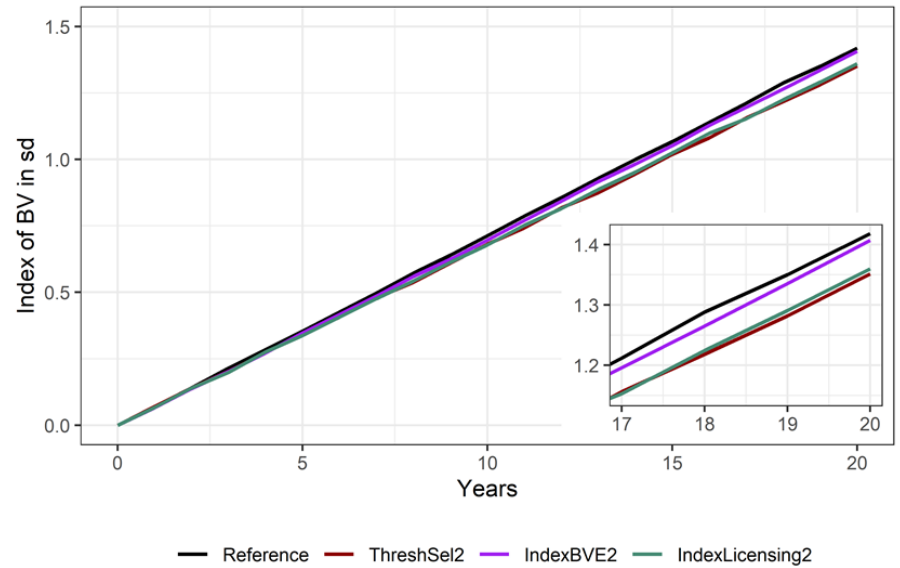
Figure 6. Average increase in breeding values in genetic standard deviations for the traits of the 50-day stallion performance test for scenarios without genomic breeding value estimation. The inset shows the period from 17 to 20 years.